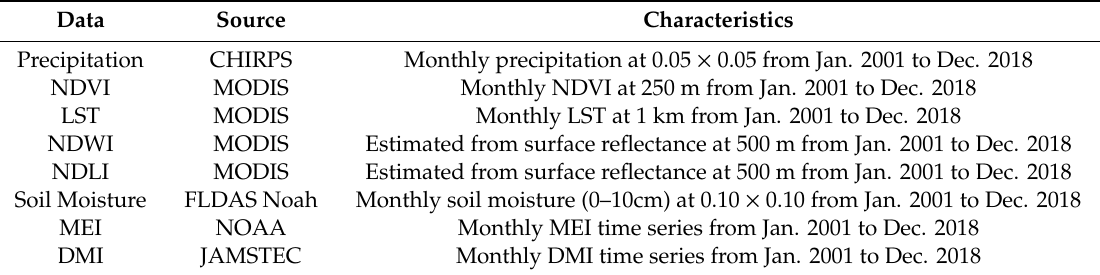
Table 1. Datasets characteristics and